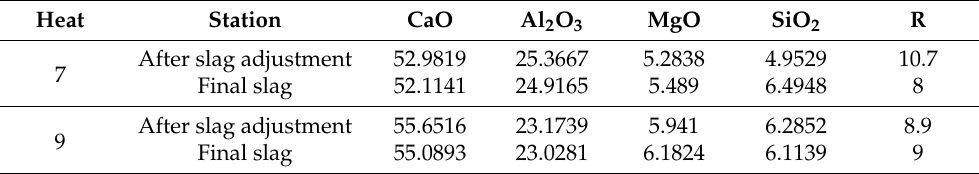
Table 6. Changes in the composition of optimized refined slag series